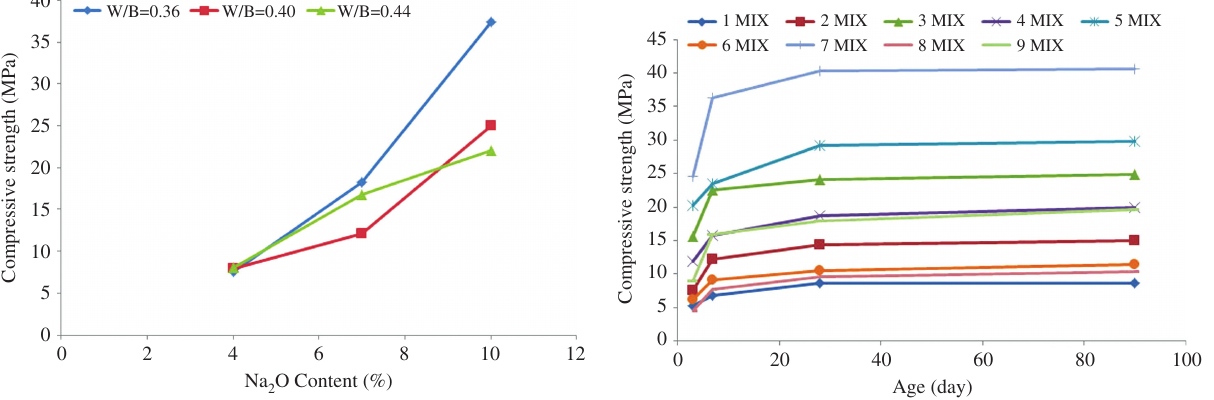
O on 28-day compressive strength for Figure 12 The effect of Na 2 samples cured at 85 ° C and constant w/b.